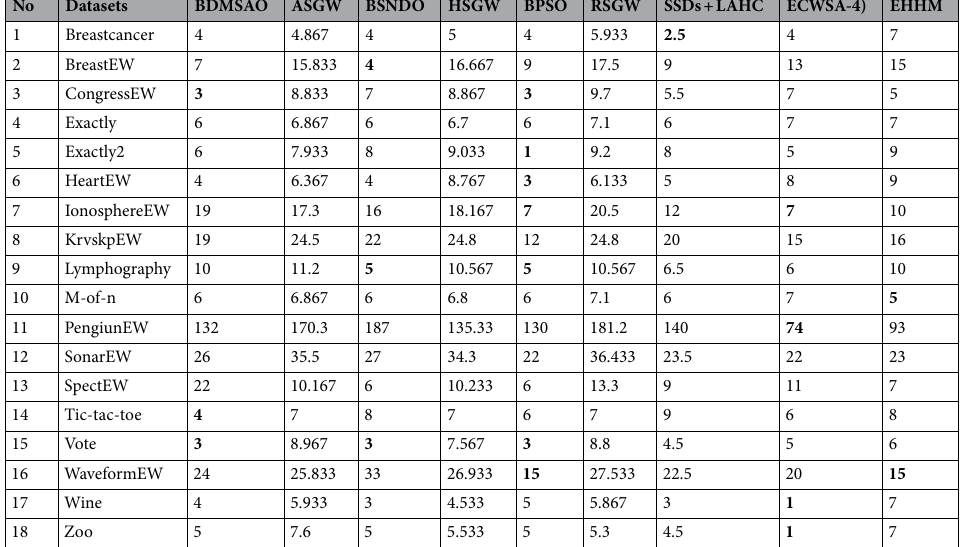
Table 6. The number of features selected by BDMSAO compared with other well-known feature selection methods tested using the UCI dataset. The highlighted results indicate the least number of feature subsets selected.